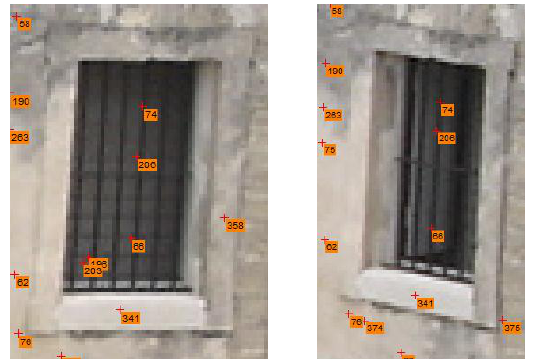
Figure 3. SURF matching results after distance threshold and one-to-one relationship restrictions